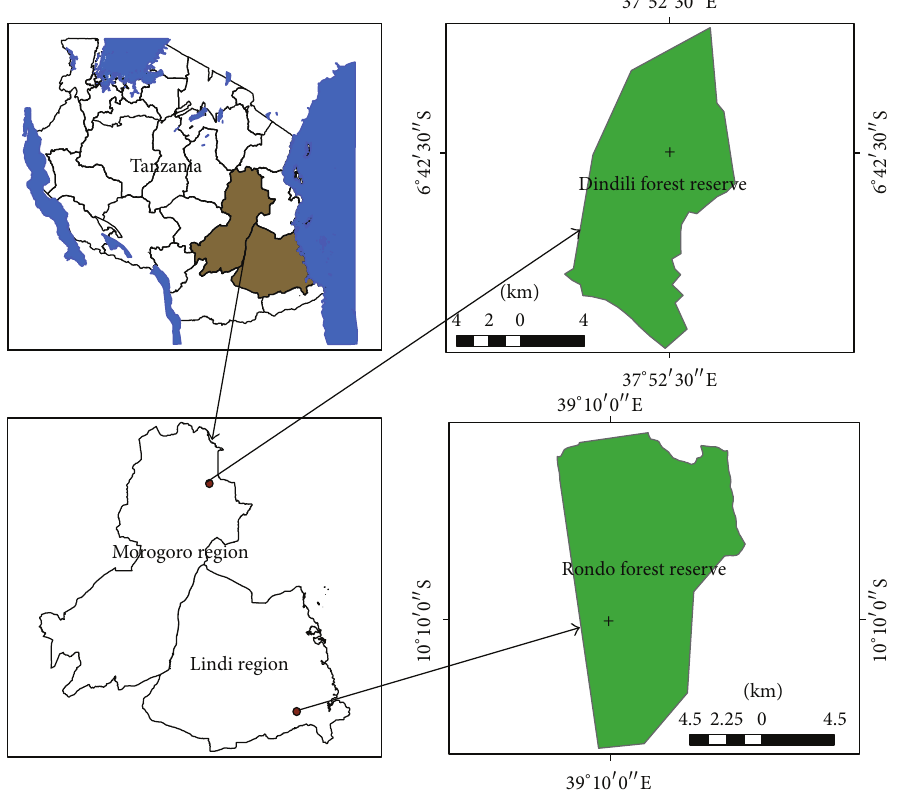
Figure 1: Location of Dindili and Rondo forest reserves. Table 1: Sample trees selection corresponding to tree size distribution in each